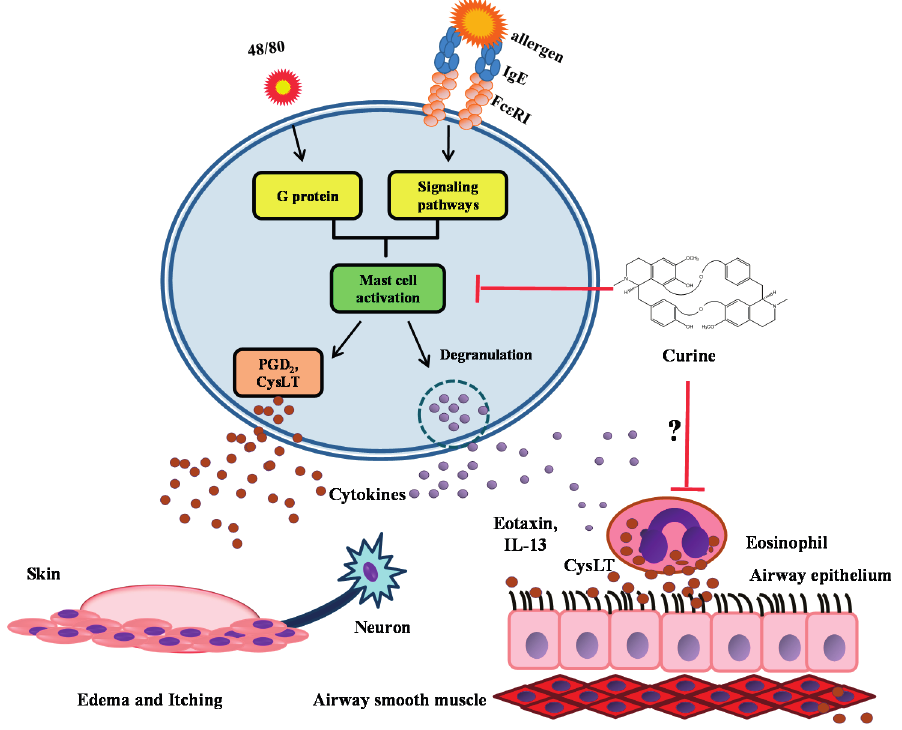
Figure 3. Mechanisms of action of curine in